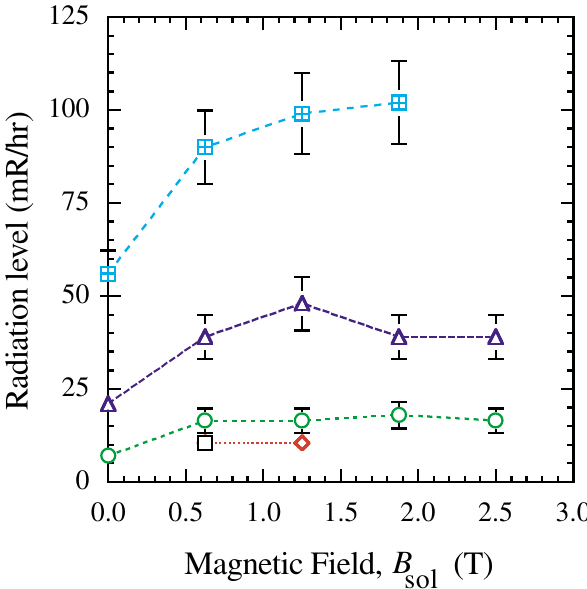
FIG. 15. (Color) Dependence of the radiation levels on the solenoidal magnetic